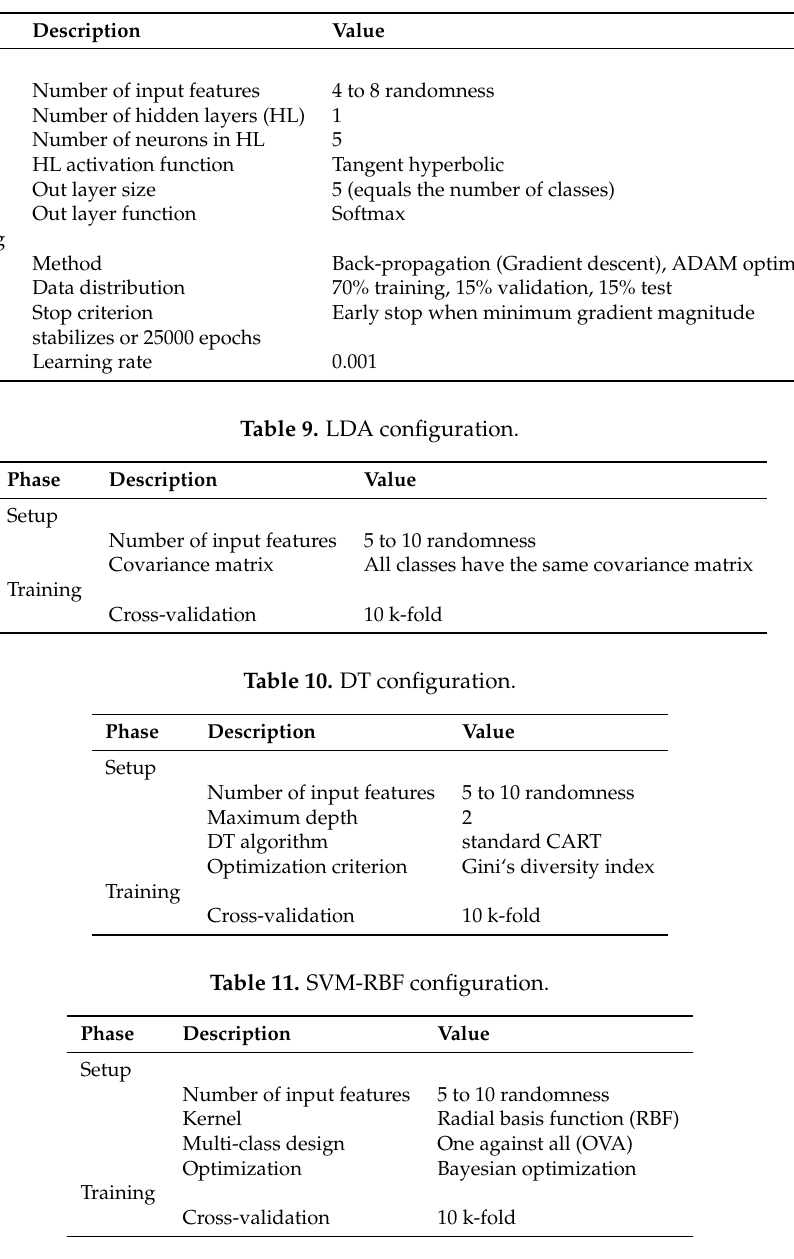
Table 8. ANN configuration.